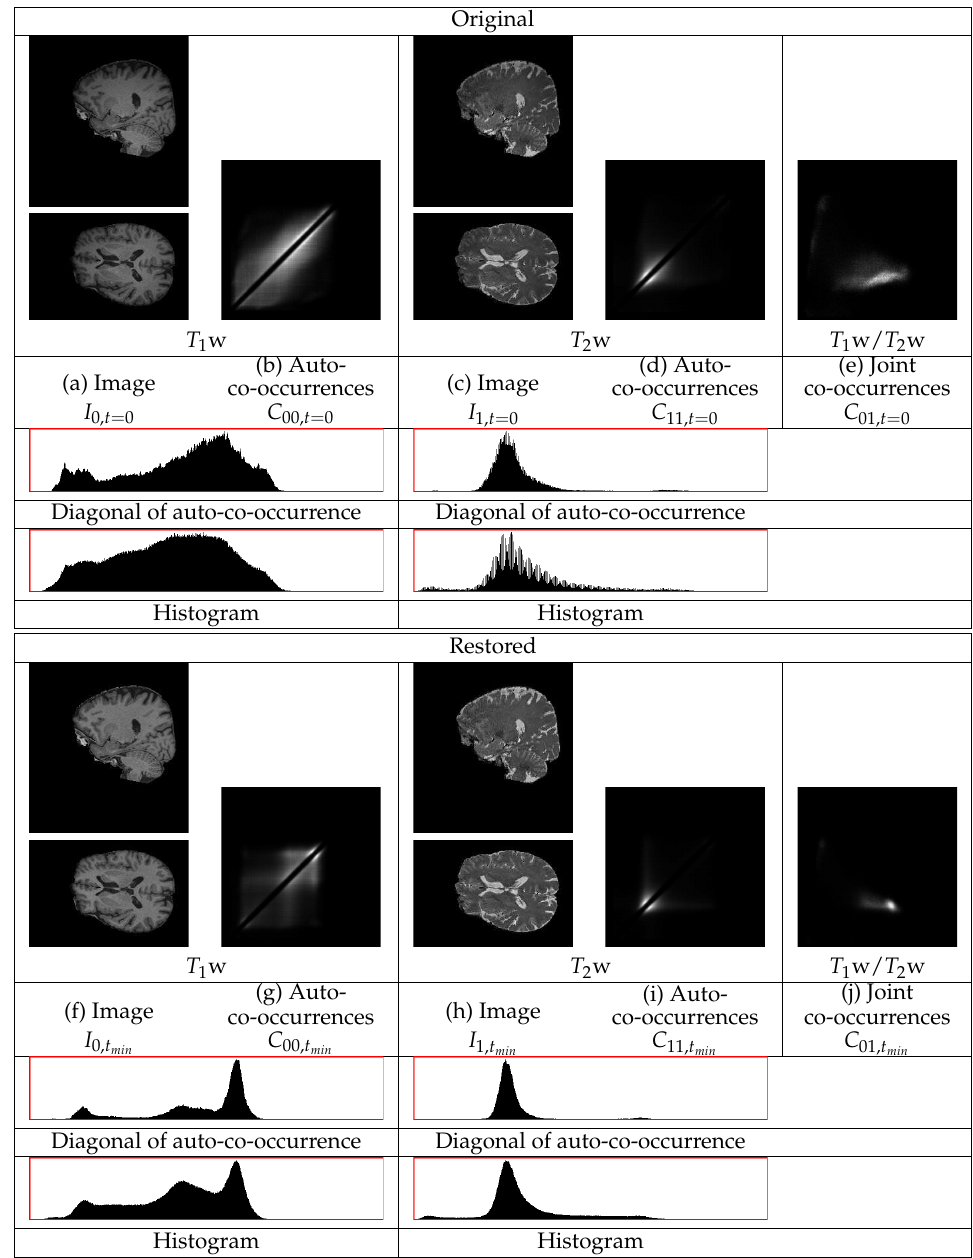
Figure 7. Example restoration of a T 1 w and a T 2 w image pair of a Parkinson’s disease patient. The intensities of the white matter in both the T 1 w image and in the T 2 w image become more uniform. The statistical distributions become